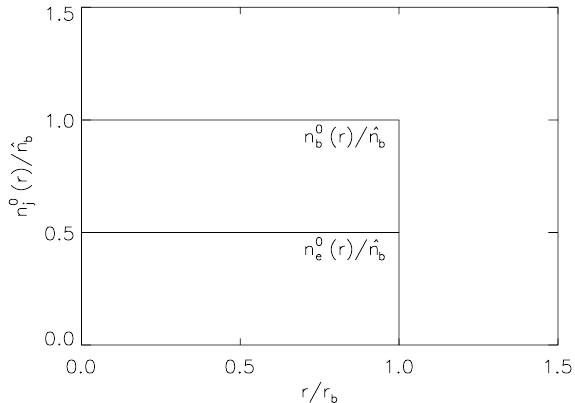
FIG. 1. Equilibrium step-function density profiles (cid:110) (cid:48) (cid:98) (cid:115) (cid:114) (cid:100) and (cid:115) (cid:114) (cid:100) [Eqs. (22) and (23)] for the choice of ion and electron (cid:110) (cid:48) (cid:101) distribution functions in Eq. (21). For the purpose of illustra- tion, we have taken (cid:90) (cid:98) (cid:173) (cid:49) and (cid:102) (cid:173) (cid:48)(cid:46)(cid:53) in the